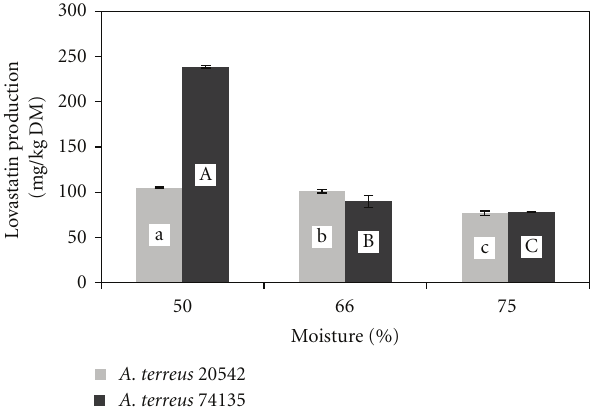
Figure 9: e ff ect of moisture content on lovastatin production by two strains of A. terreus ( P < 0 . 01). (a, b, and c) indicate di ff erences among means between samples for A. terreus ATCC 20542. (A, B, and C) indicate di ff erences among means between samples for A. terreus ATCC 20542.